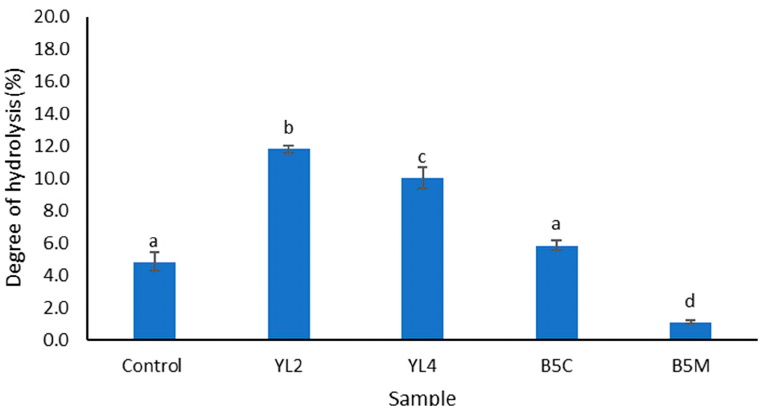
Figure 2. Degree of hydrolysis (DH) expressed in percentage for the samples and measured after 72 h incubation. YL2 and YL4 ( Y. lipolytica ), B5C ( B. subtilis ), and B5M ( B. amyloliquefaciens ). Results are the average of three replicates ( n = 3). Different letters mean results are significantly different ( p < 0.05).